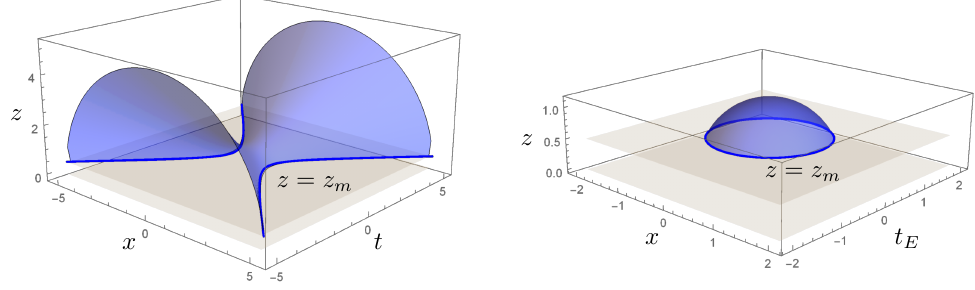
Figure 2 . Left: Lorentzian string solution dual to a pair of particles undergoing constant proper acceleration. Right: string solution dual to the Euclidean instanton. In both cases the solutions are truncated at some z = z m where the embeddings coincide with the boundary Lorentzian and Euclidean trajectories, (2.5) and (2.6),